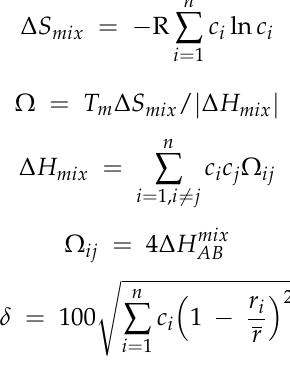
Figure 2. Tensile engineering stress–strain curve for Zr 58 Cu 15.46 Ni 12.74 Al 10.34 Nb 2.76 Y 0.5 bulk metallic glass (BMG).